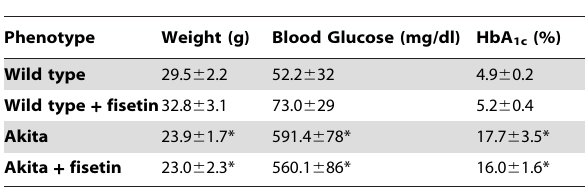
Table 1. Metabolic Parameters at the end of the